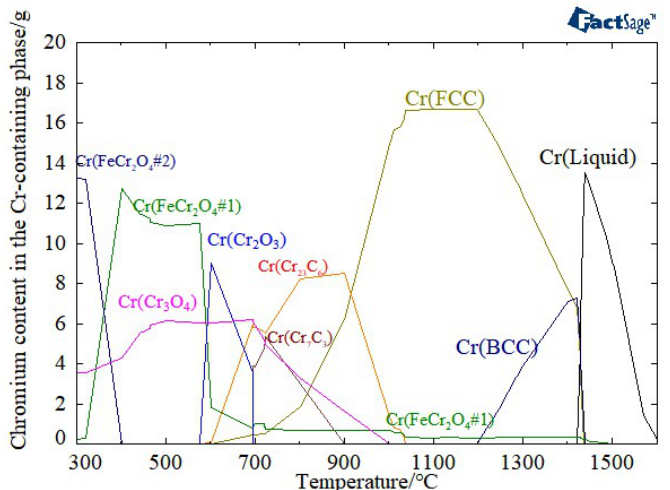
Figure 8. Content of Cr-containing phase at 10 −4 atm and different temperature.